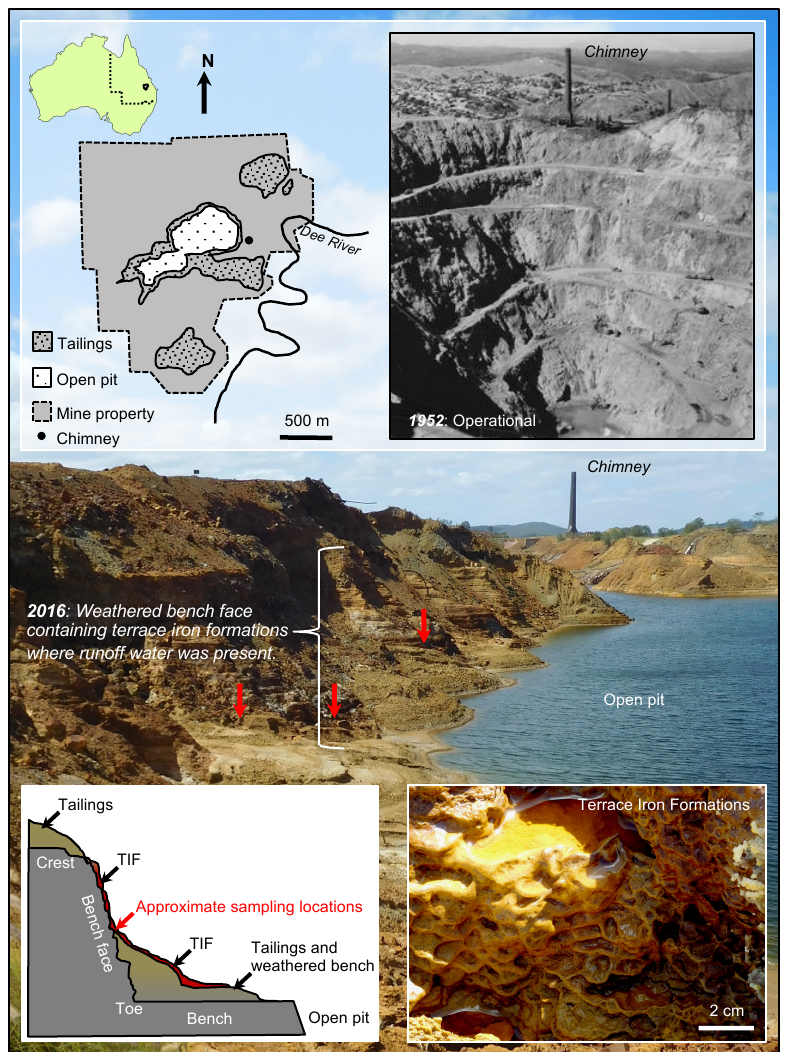
Figure 2. A schematic diagram of the Mount Morgan mine illustrating the deposition of mine tailings within the mine property and the sampling location (red arrows). The historic photograph, courtesy of State Library of Queensland, demonstrates the depth of the open pit during operation in 1952. Terrace iron formations had formed on weathered bench faces and on tailing